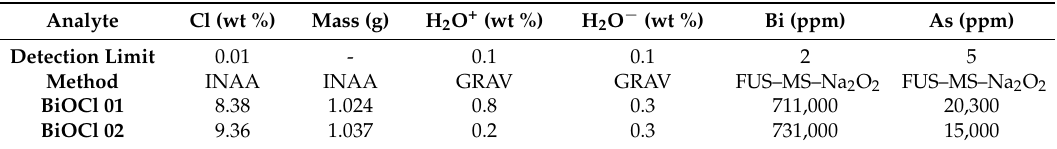
Table 5. Chemical results provided by Actlabs Ltd for bismoclite–preisingerite bearing samples from San Francisco de los Andes.